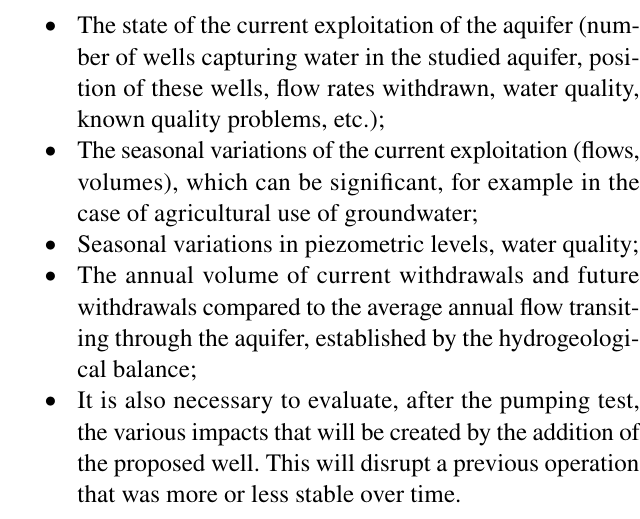
Table 3 Calculation results of the hydrodynamic parameters (T.K.S) of the Mougheul aquifer (Mebarki 2021)